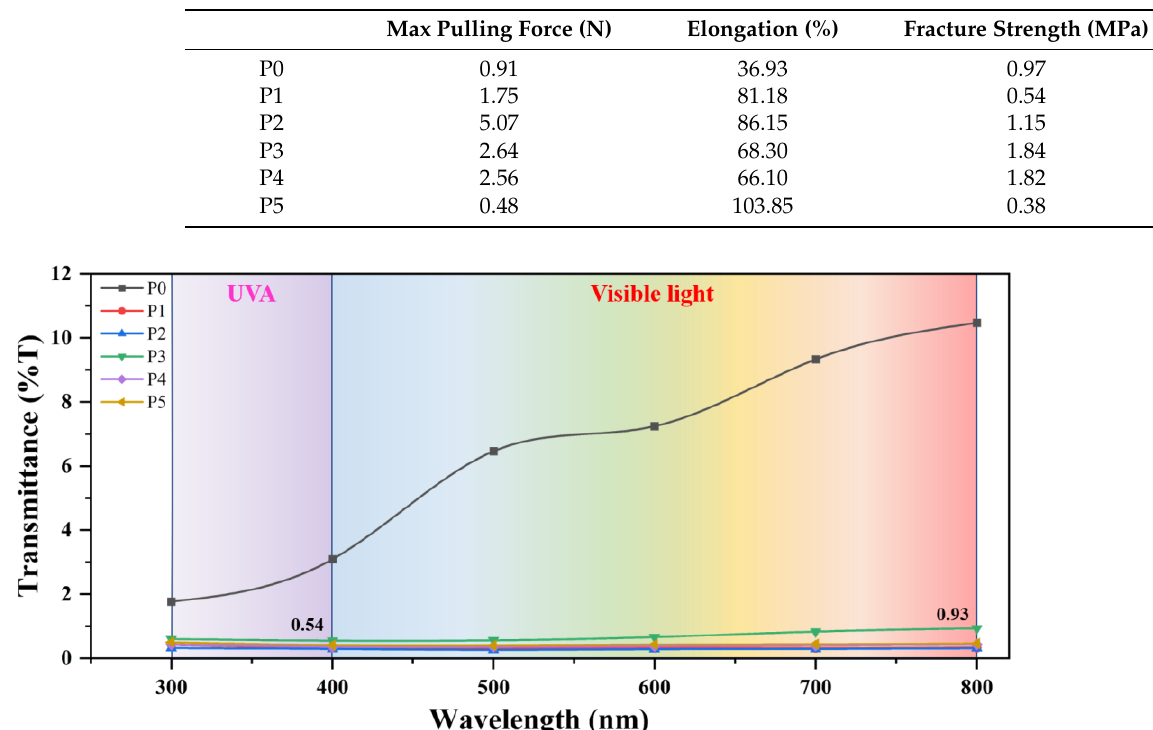
Figure 7. The transmittance of PDMS/PVDF membrane to ultraviolet and visible